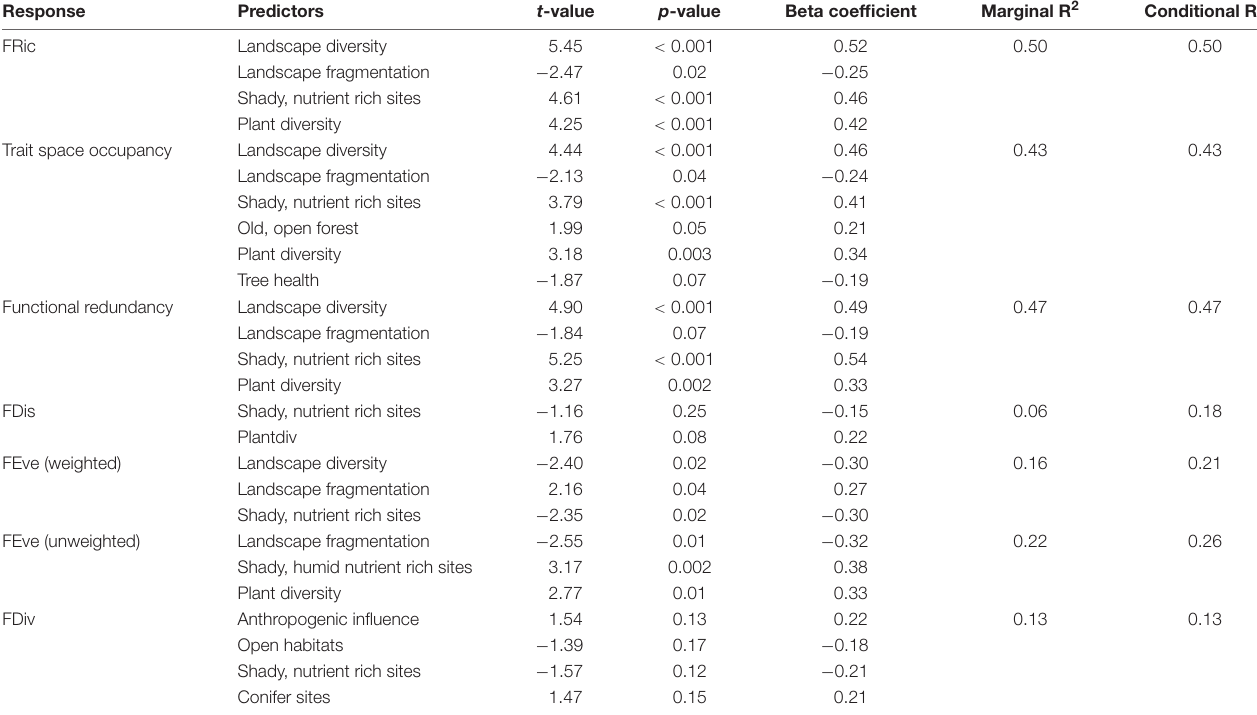
TABLE 3 | Best models for seven different functional diversity indices (as response variables) and multiple predictors tested simultaneously, selected via AIC.